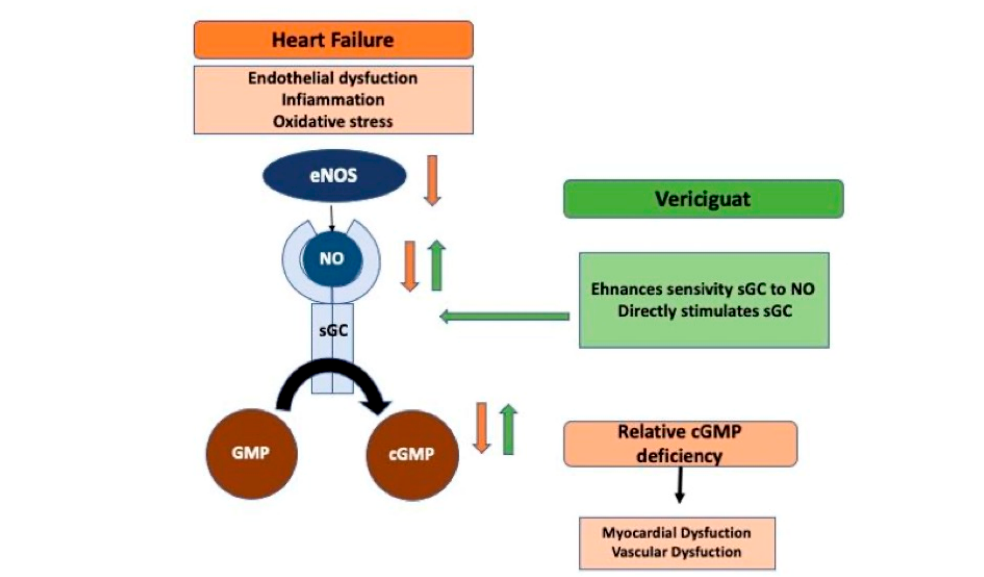
Figure 1. Mechanisms of action of vericiguat. cGMP= cyclic guanosine monophosphate; eNOS = endothelial nitric oxide synthase; GMP = guanosine monophosphate; NO = nitric oxide; sGC = sol ‐ uble guanylate cyclase. Adapted with permission from Ref. [12]. Copyright 2021, Arrigo Mattia.